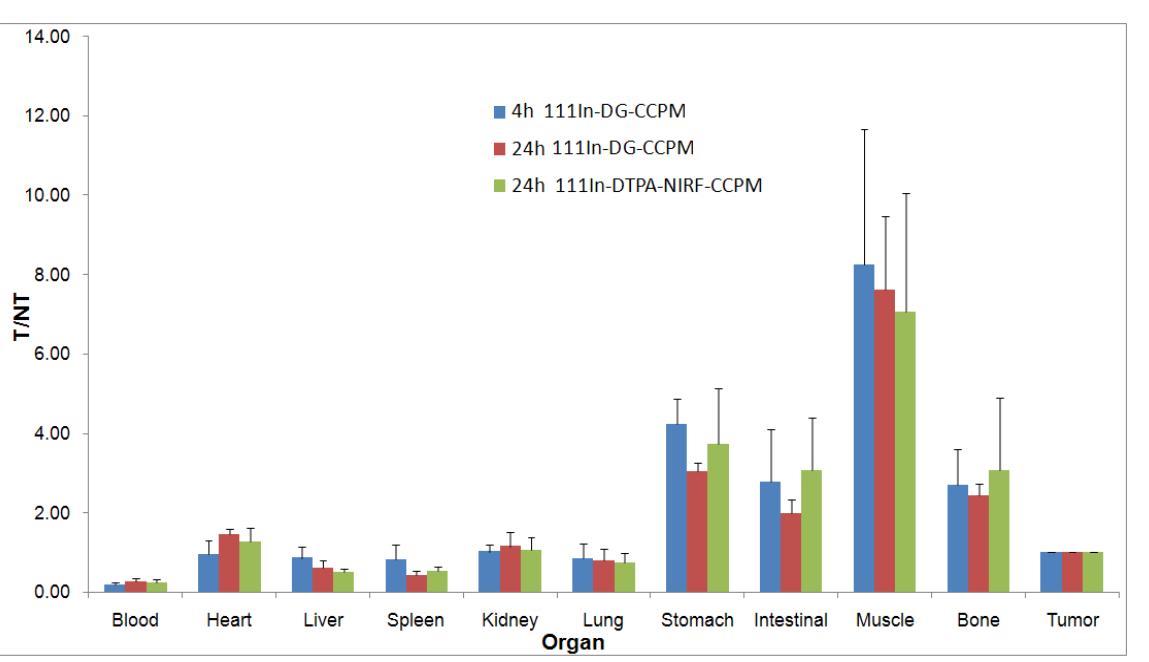
Figure 5. Comparison of tumor-to-normal tissue uptake ratio (T/NT) between 111 In-DTPA- NIRF-CCPM and 111 In-DG-CCPM in nude mice bearing A 431 tumors at 4 h and 24